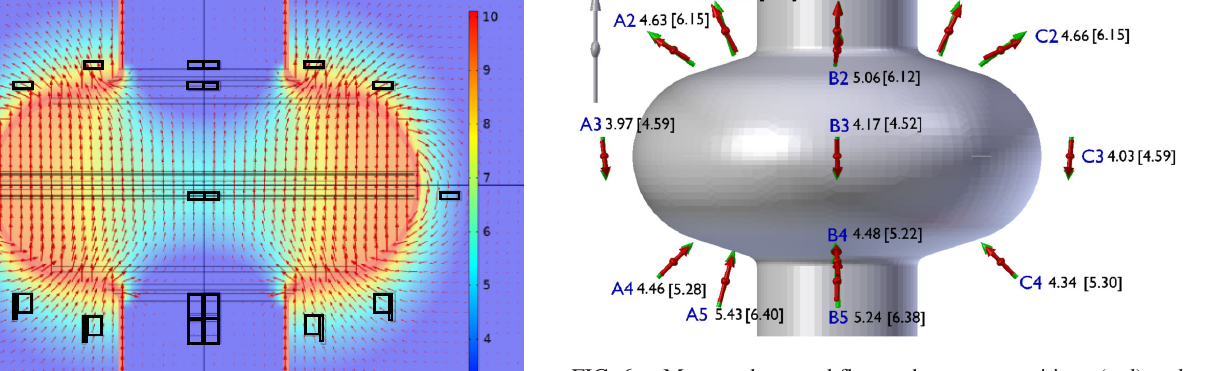
FIG. 6. Measured trapped flux at the sensor positions (red) and simulation results for homogeneous trapping (green). External field is applied in the direction of α ¼ 90 °. Numbers next to the arrows show the magnitude of the measured magnetic flux density in μ T. Numbers in brackets show the magnitude of the simulated magnetic flux density in μ T. The gray arrow indicates the direction of the applied field, but it is not to scale. The sensor labels are marked in blue. Due to a broken sensor, sensor group C5 is not